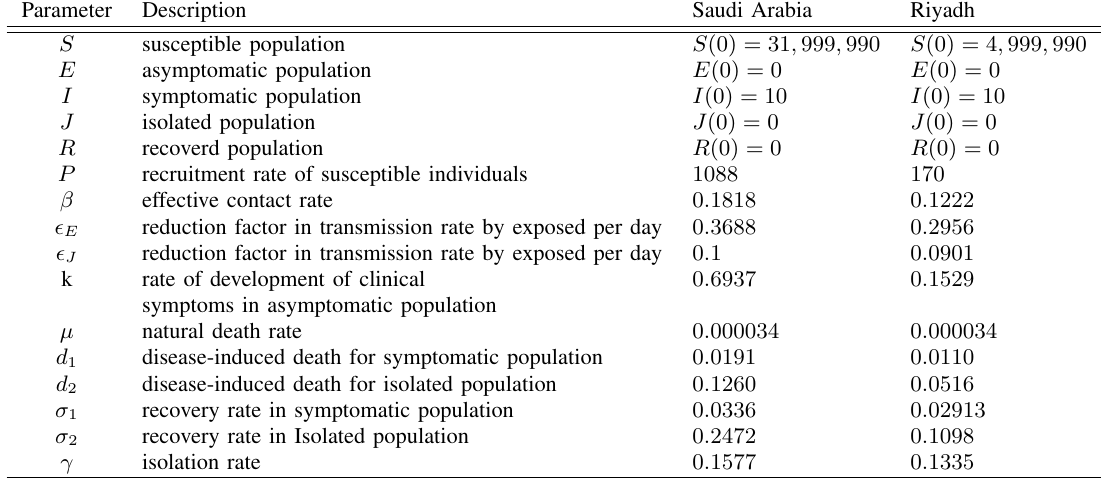
TABLE I: Model baseline parameters for Saudi Arabia and Riyadh